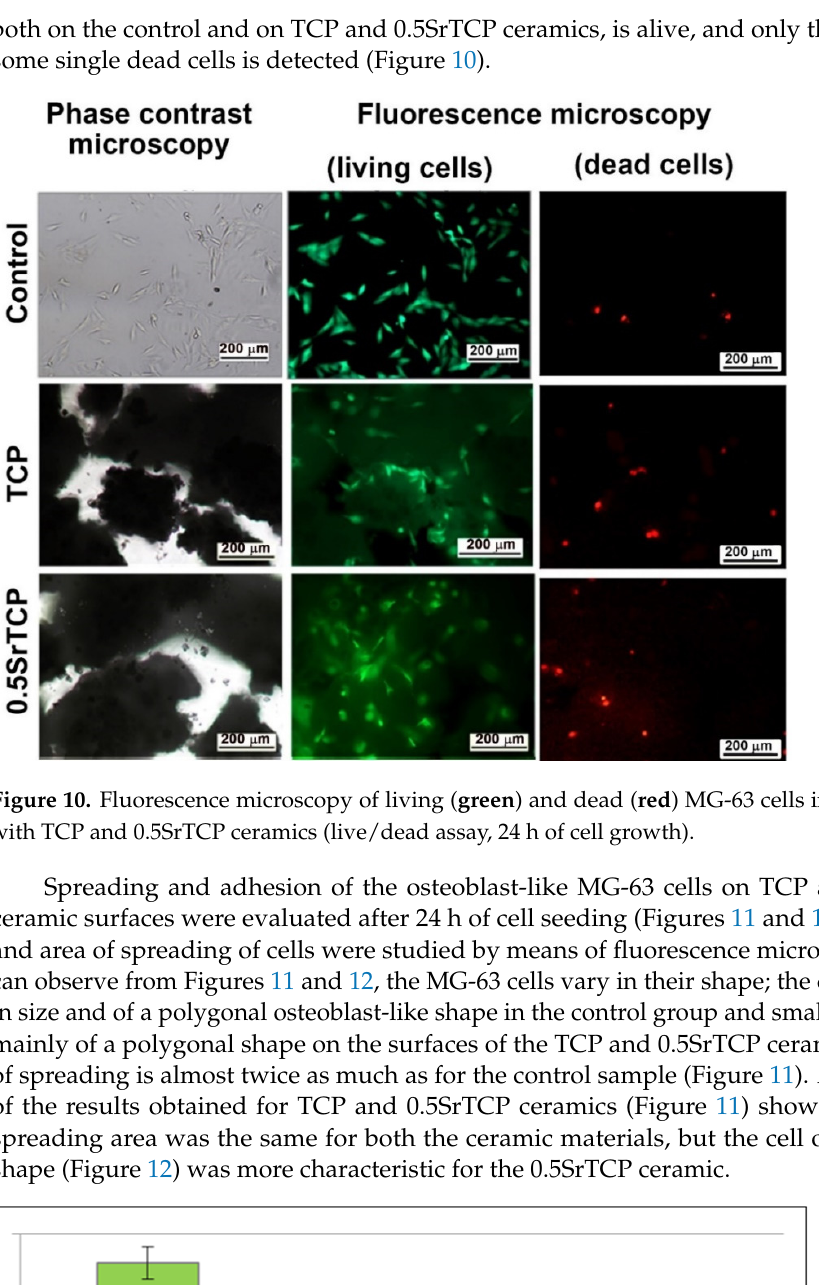
both on the control and on TCP and 0.5SrTCP ceramics, is alive, and only the presence of some single dead cells is detected (Figure 10).